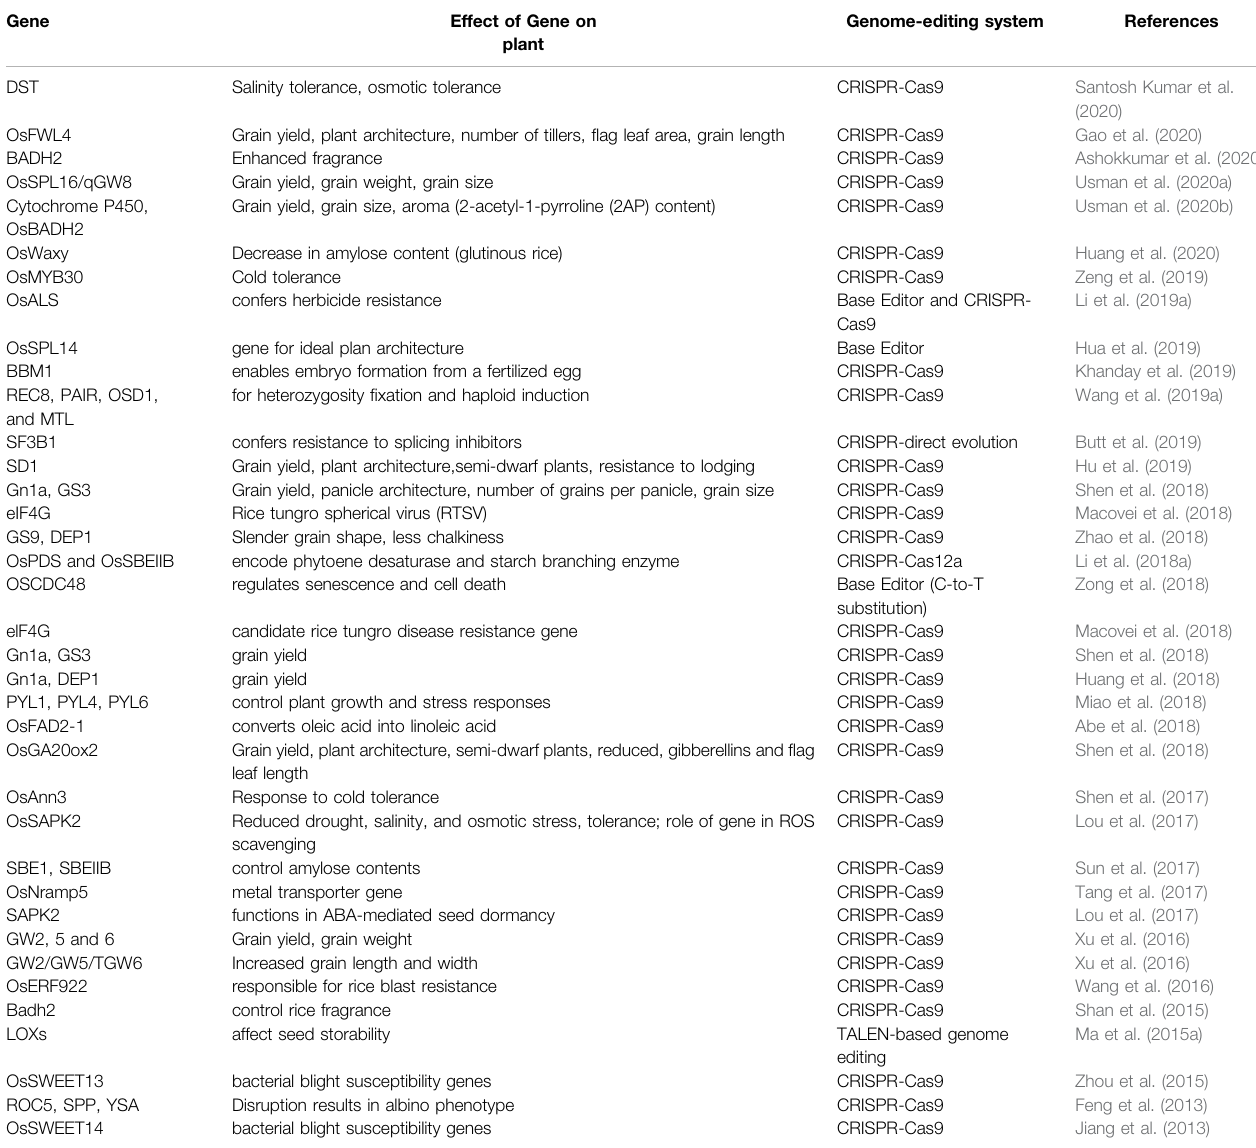
TABLE 1 | Summary of gene edited traits in rice. Gene Effect of Gene on